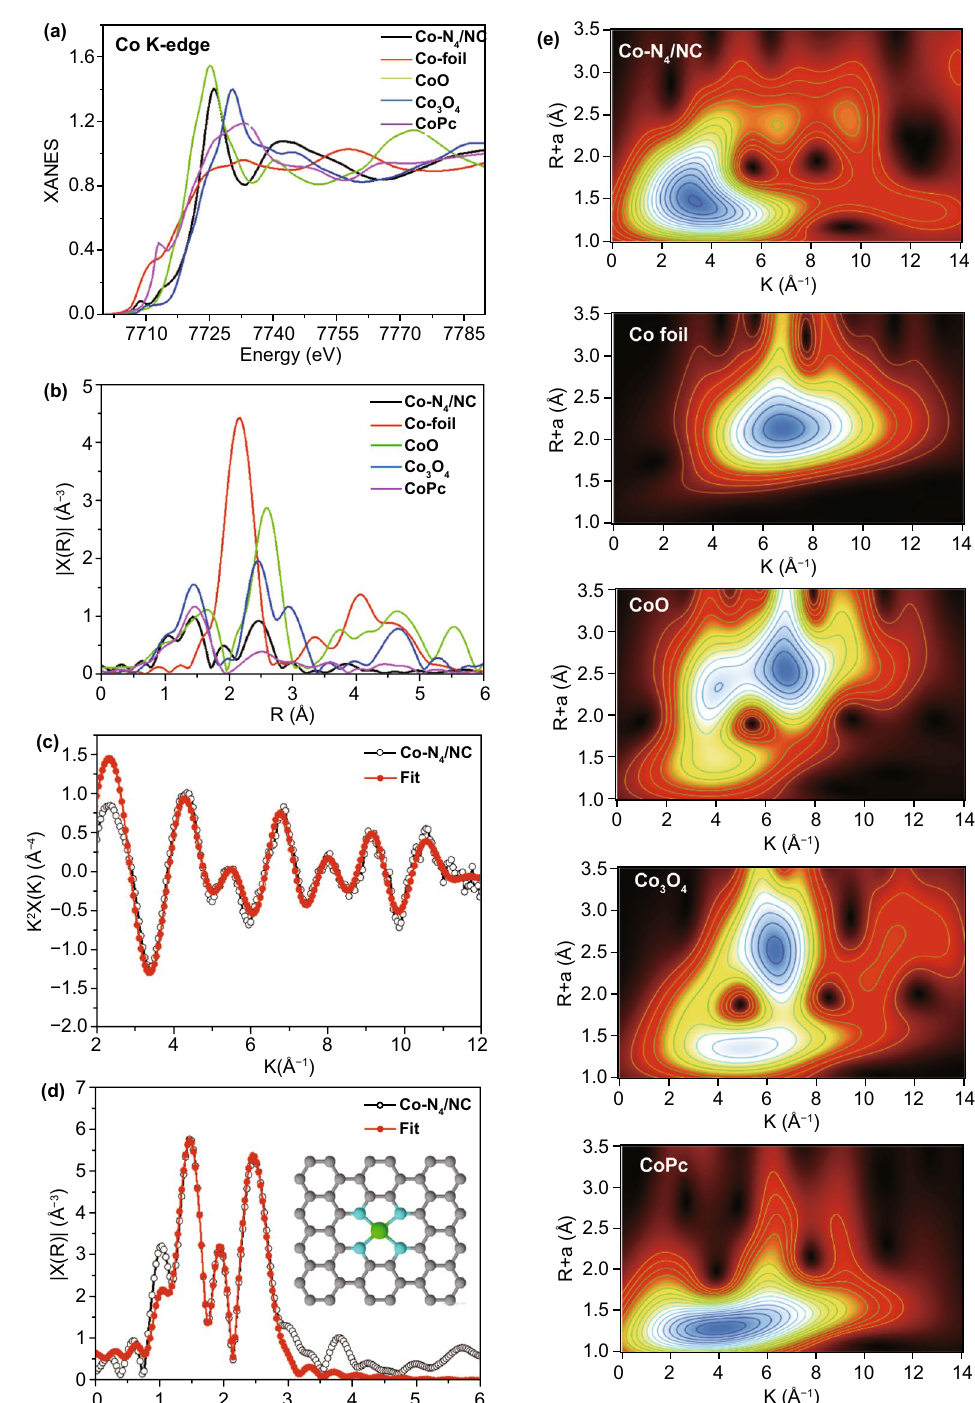
Fig. 4 The local electronic state and chemical environment of Co-N 4 /NC. a Comparison of Co K-edge XANES spectra of Co foil, CoO, Co 3 O 4 , CoPc, and Co-N 4 /NC. b Fourier transform of the EXAFS spectra of Co foil, CoO, Co 3 O 4 , CoPc, and Co-N 4 /NC. c , d EXAFS analysis of Co-N 4 / NC at K and R space. The inset in d demonstrates the model derived from the EXAFS results. e Wavelet transform of Co K-edge XANES spec- tra of Co foil, CoO, Co 3 O 4 , CoPc, and Co-N 4